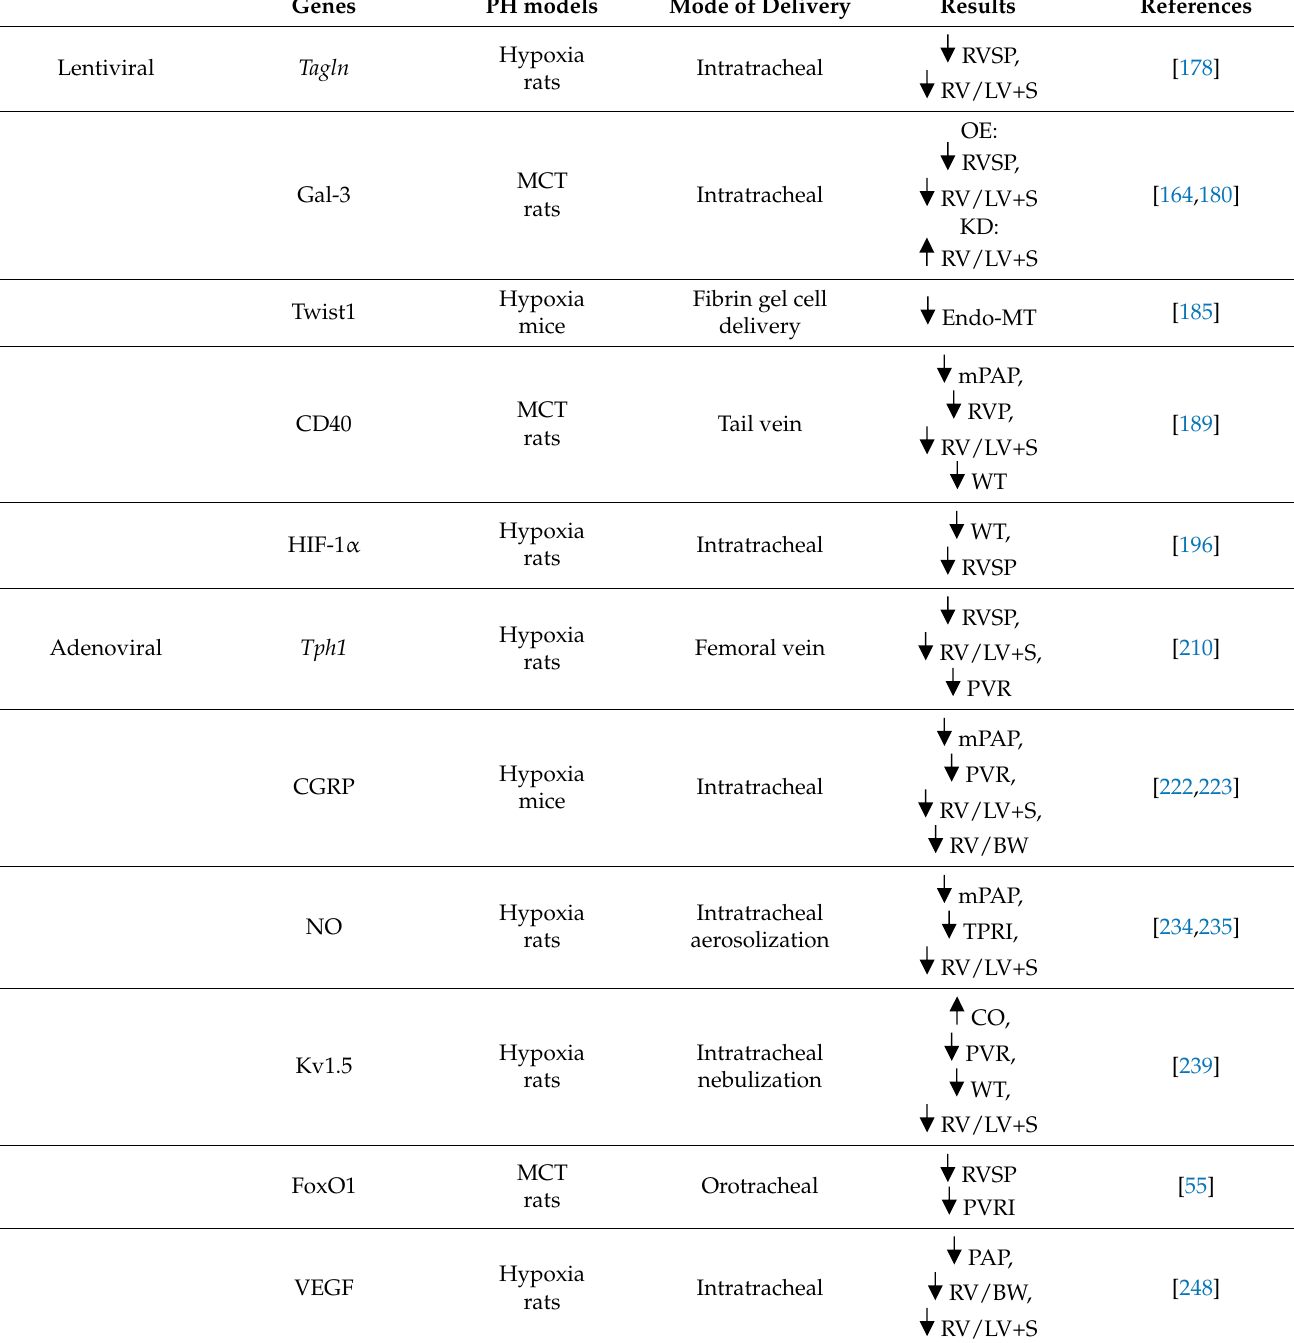
Table 1. An overview of different viral gene therapy approaches in pulmonary hypertension. Angiopoietin 1 (Ang-1); Bone morphogenetic protein receptor type 2 ( BMPR2 ); Cluster of differentiation 40 (CD-40); Calcitonin gene-related peptide (CGRP); Galectin-3 (Gal-3); Forkhead box O1 ( FoxO1 ); Hypoxia inducible factor-1 α (HIF-1 α ); Interleukin 10, (IL-10); Nitric Oxide (NO); Prostacyclin synthase (PGIS); Sarco-/endoplasmic reticulum calcium-ATPase 2a (SERCA2a); Tissue inhibitor matrix metalloproteinase 1 (TIMP-1); Transgelin ( Tagln ); Tryptophan hydroxylase-1 ( Tph1 ); Tyrosine-protein kinase receptor (Tie2); Twist related protein 1 (Twist); Vascular endothelial growth factor (VEGF); Voltage-gated potassium channel member 5 (Kv1.5); Mean pulmonary arterial pressure (mPAP); right ventricular systolic pressure (RVSP); ratio of right ventricular weight to left ventricle plus septum (RV/LV+S); wall thickness (WT); pulmonary arterial systolic pressure (PASP); pulmonary arterial diastolic pressure (PADP);% of muscularization of pulmonary arteries (% musc); pulmonary vascular resistance index (PVRI).